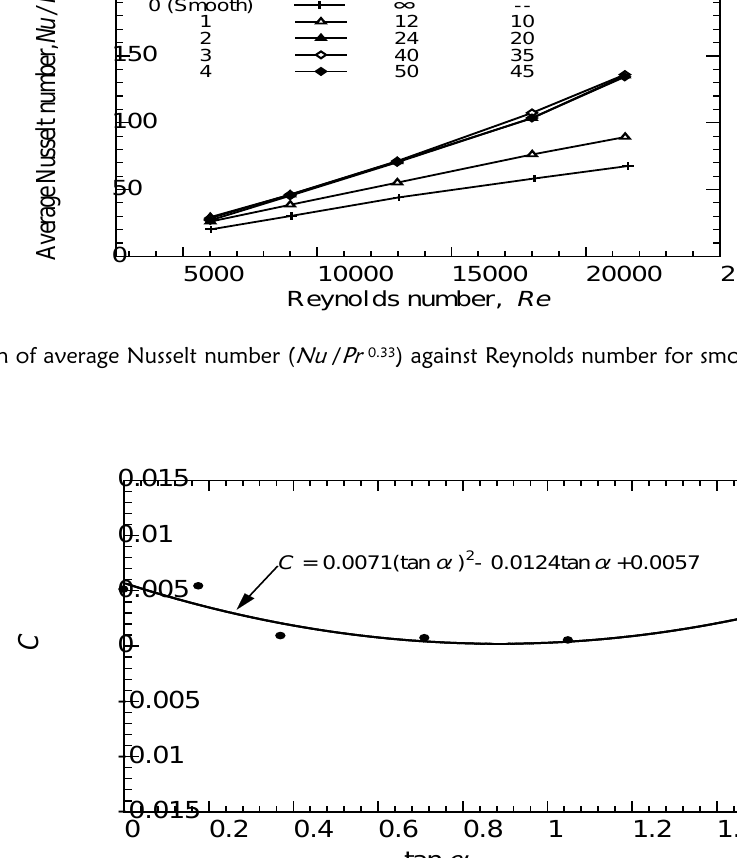
Figure 10: Variation of c against tan α for smooth tube and wire-coil inserted